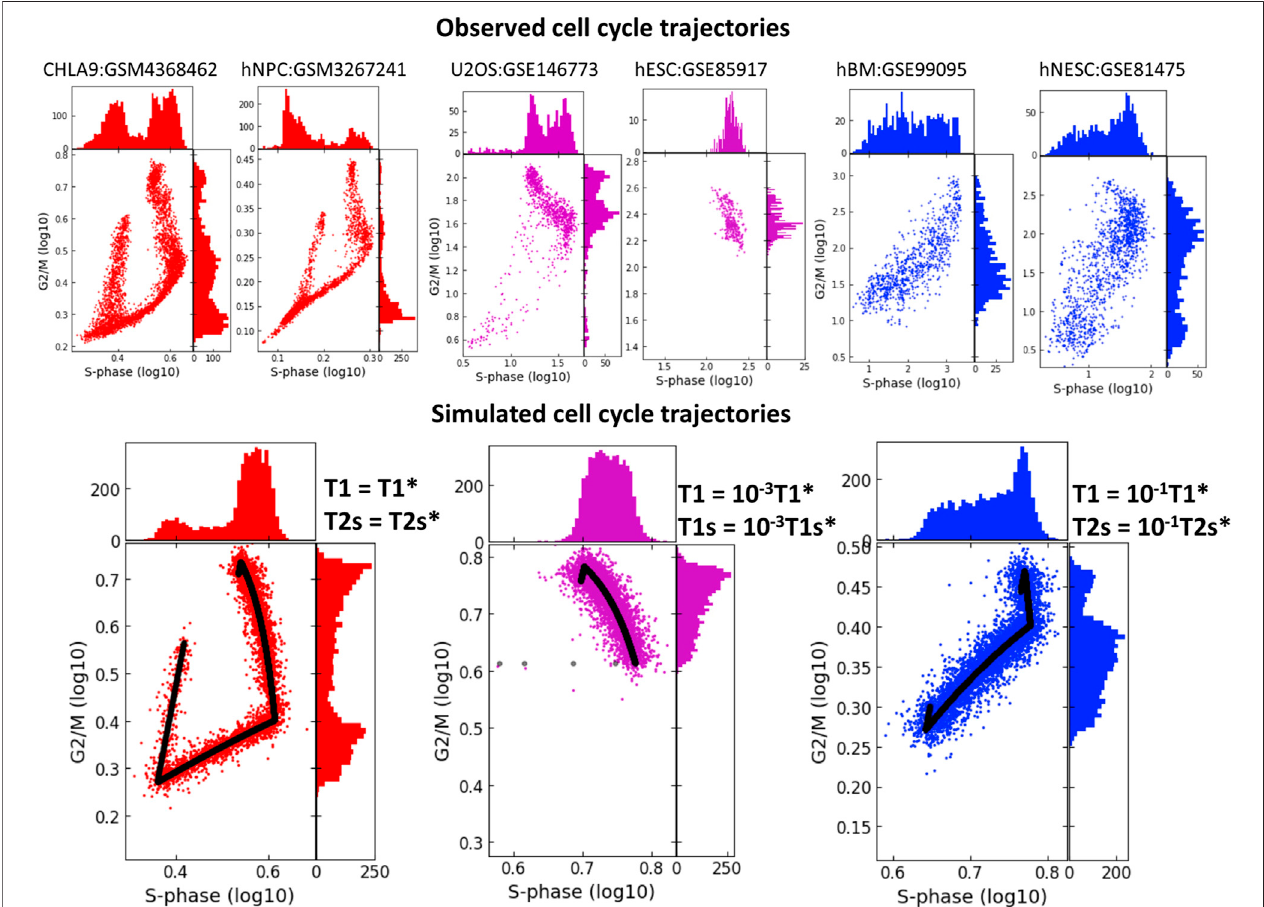
FIGURE 7 | Studying the effect of shortening the durations of transcriptional epochs T1 and T1s or T1 and T2s on the geometry of cell cycle trajectory projected onto the S-phase and G2/M-phase scores plane. The simulated trajectories (in the lower part of the fi gure) are produced by taking the parameters of the CHLA9 fi t of model dynamics (red plot) and changing the durations of T1 and T1s epochs (violet plot) or the durations of T1 and T2s epochs (blue plot). Each simulation shows the trajectory (black line) sampled with Laplacian noise added, with score distribution histograms shown at the plot margins. The upper part of the plot shows six real- life cell cycle trajectories observed in different systems, with GEO identi fi ers indicated. In each plot title either cell line name is provided, or hNPC means human neural precursor cells, hESC - human embryonic stem cell, hBM - human bone marrow, hNESC - human neural epithelial stem